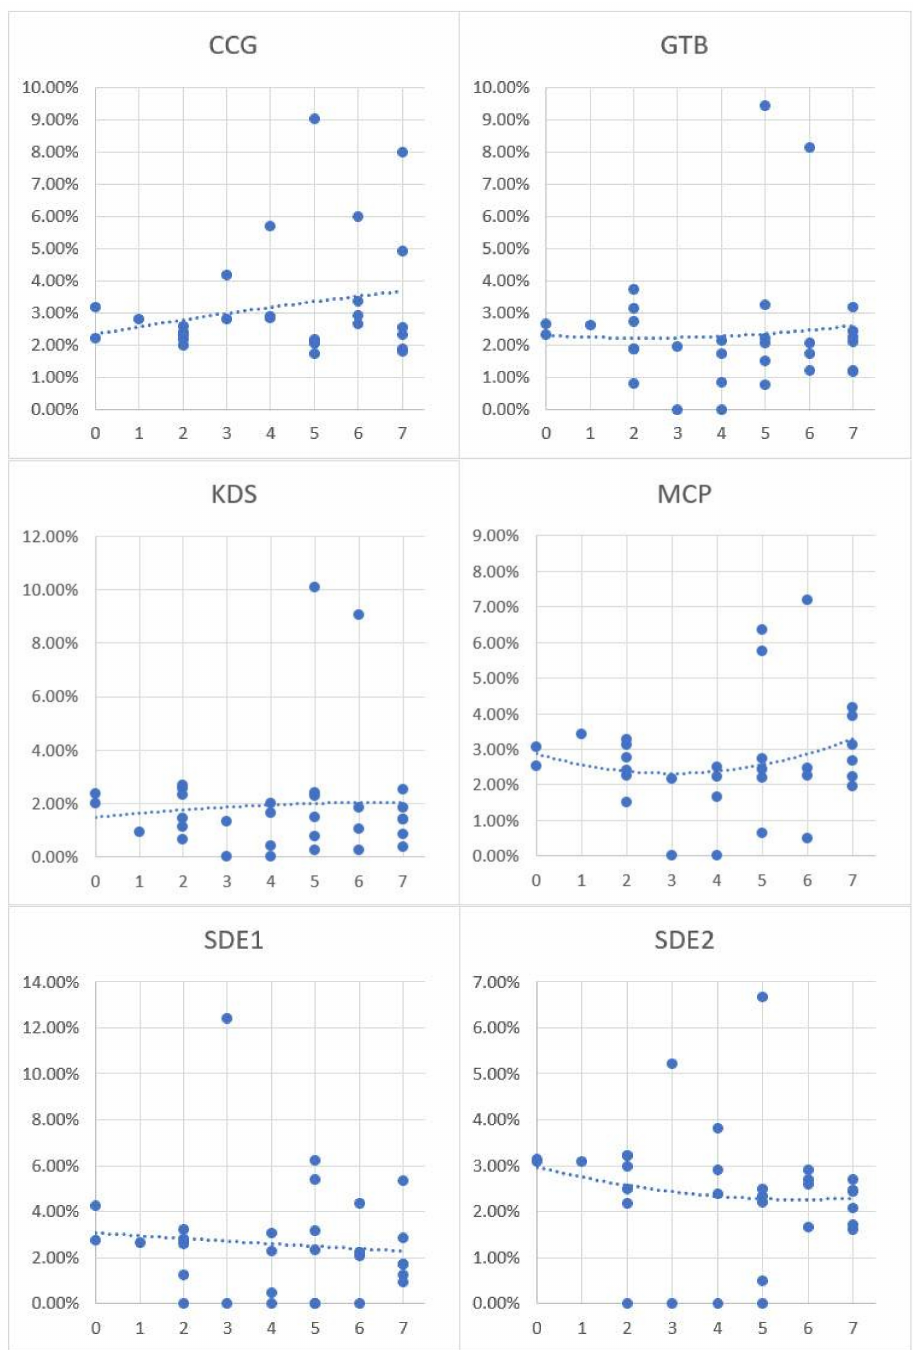
Figure 12. The correlation between physical-activity-friendly contextual exposures and physical activity level. (Vertical axis: the physical-activity-friendly contextual exposures level; horizontal axis: physical active days per week; trend lines are generated using the 2nd order polynomial fitting